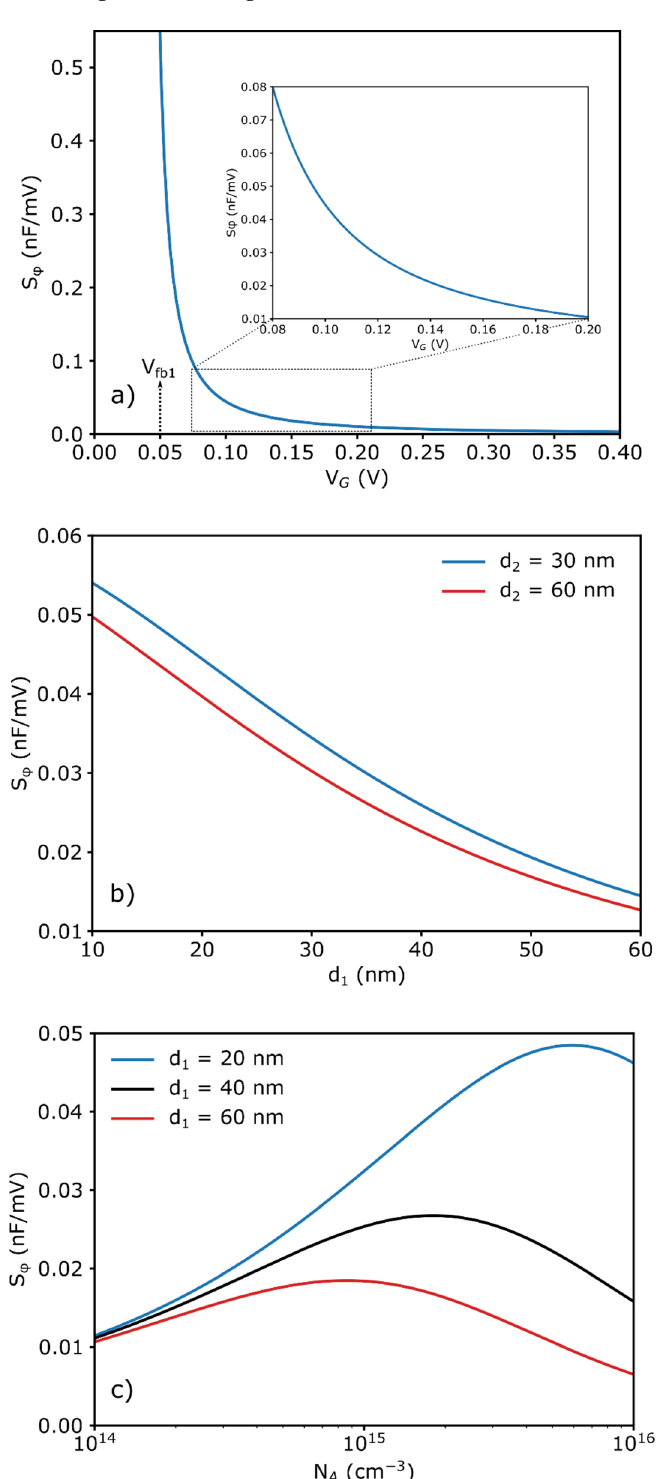
Figure 8. ( a ) Sensitivity of the CG-EISCAP chip as a function of gate voltage, ( b ) thickness of insulator-1 and insulator-2 and ( c ) doping concentration. Simulation parameters for ( a ): d 1 = 20 nm, d 2 = 30 nm, N A = 2.76 × 10 15 cm − 3 , ϕ 1 = − 0.05 V; for ( b ): N A = 2.76 × 10 15 cm − 3 , V G = 0.1 V, ϕ 1 = − 0.05 V; for ( c ): d 2 = 30 nm, V G = 0.1 V, ϕ 1 = − 0.05 V.